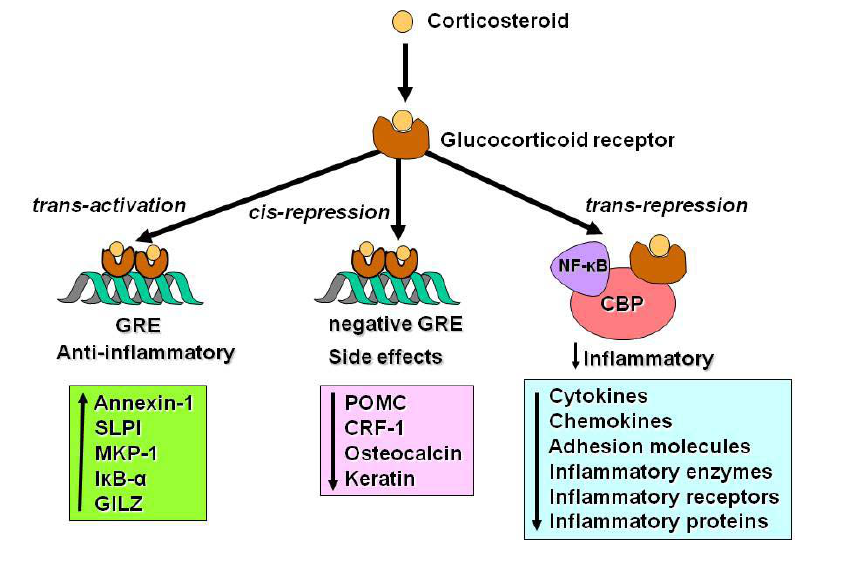
Figure 3. Corticosteroids may regulate gene expression in several ways. Glucocorticoids enter the cell to bind to glucocorticoid receptors in the cytoplasm that translocate to the nucleus. GR homodimers bind to glucocorticoid-response elements (GRE) in the promoter region of steroid-sensitive genes, which may encode anti-inflammatory proteins. Less commonly, GR homodimers interact with negative GREs to suppress genes, particularly those linked to side effects of corticosteroids. Nuclear GR also interact with coactivator molecules, such as CREB-binding protein (CBP), which is activated by proinflammatory transcription factors, such as nuclear factor- κ B (NF- κ B), thus switching off the inflammatory genes that are activated by these transcription factors. Other abbreviations: SLPI: secretory leukoprotease inhibitor; MKP-1: mitogen-activated kinase phosphatase-1; I κ B- α : inhibitor of NF- κ B; GILZ: glucocorticoid-induced leucine zipper protein;